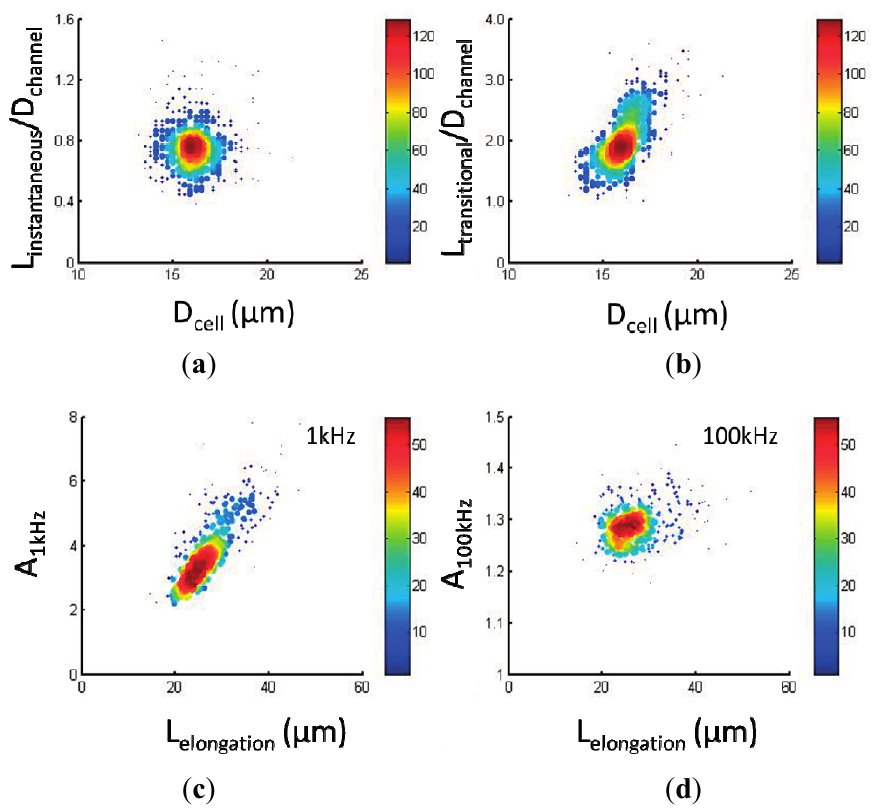
Figure 4. ( a – d ) Scatter plots of raw mechanical data of L instantaneous /D channel vs. D cell ( a ) and L transitional /D channel vs. D cell ( b ) as well as raw electrical data of A 1kHz vs. L cell elongation ( c ) and A 100kHz vs. L cell elongation ( d ) for 95C cells ( n =